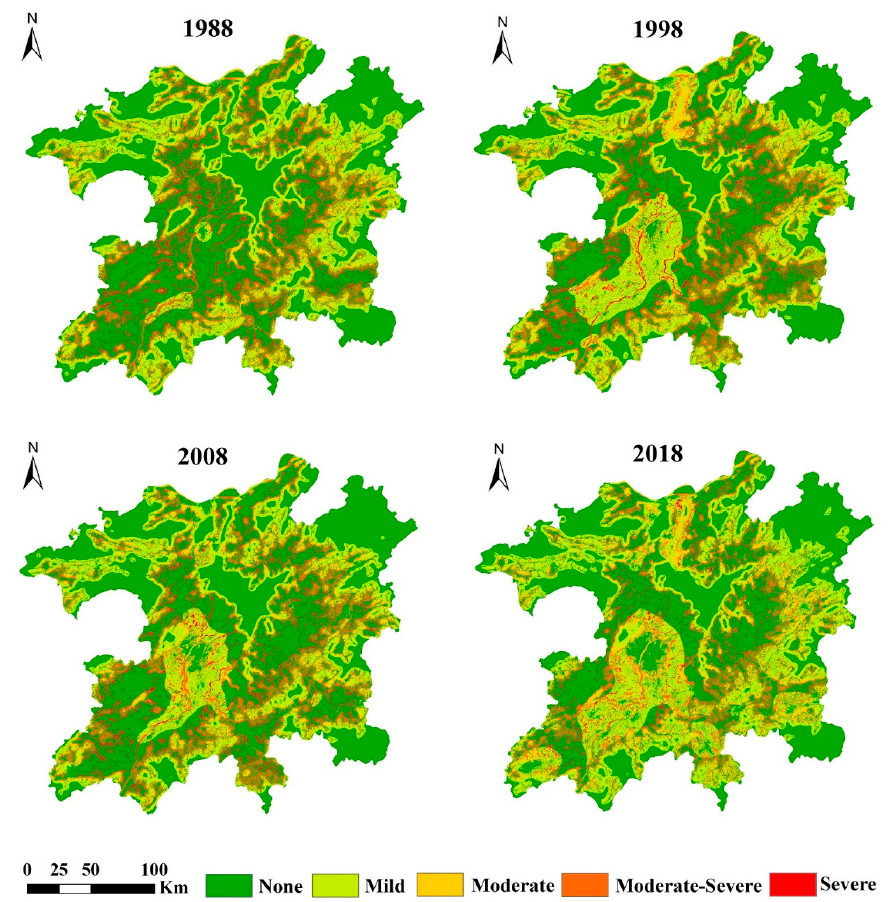
Figure 7. Spatial distribution of the habitat degradation levels in the PLEEZ from 1988–2018.